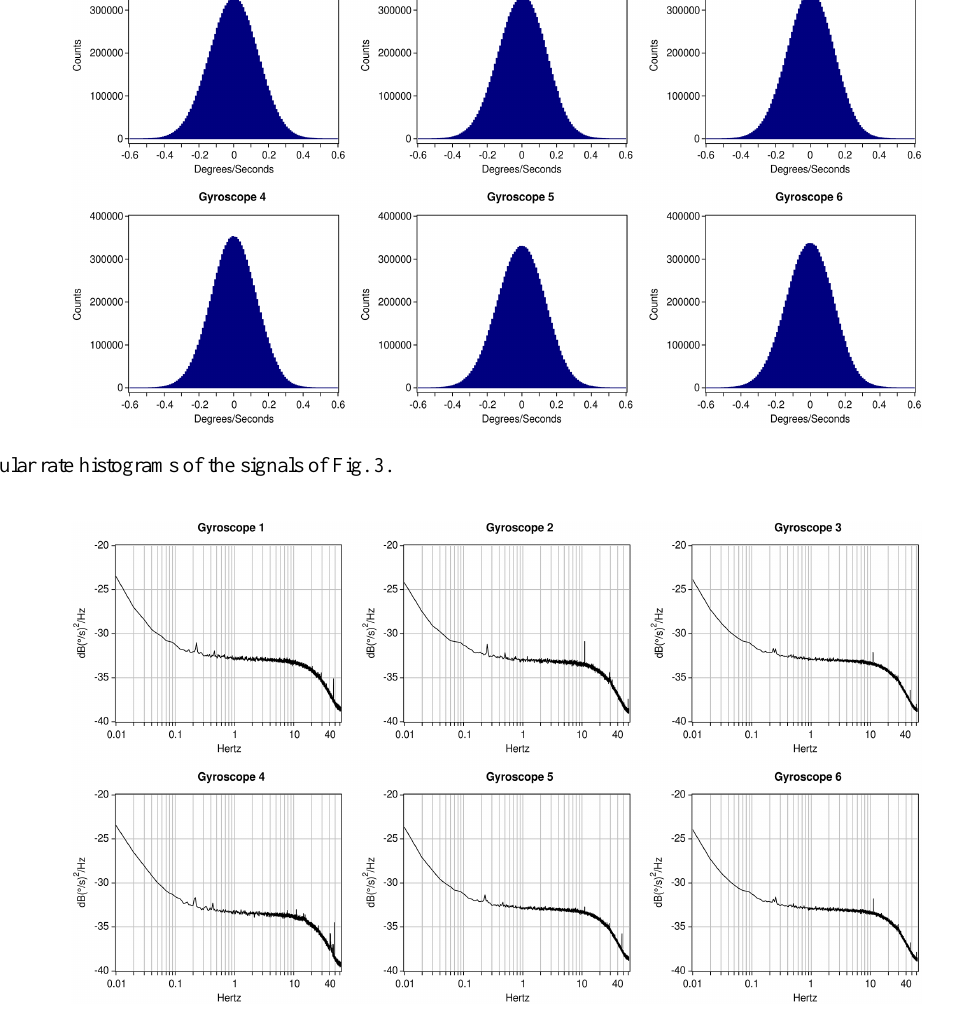
Figure 5. Angular rate PSD of the signals of Fig.